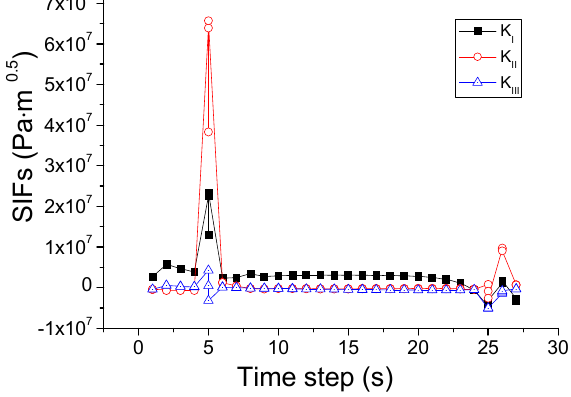
Figure 12. Variation of SIFs associated with the mixed-mode criterion based on SIFs.